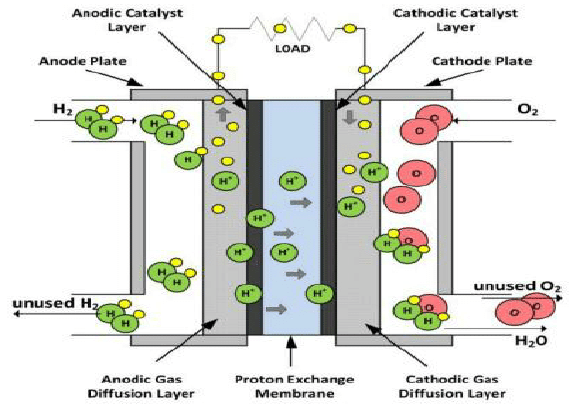
Figure 3. Schematic illustration of PEMFC.